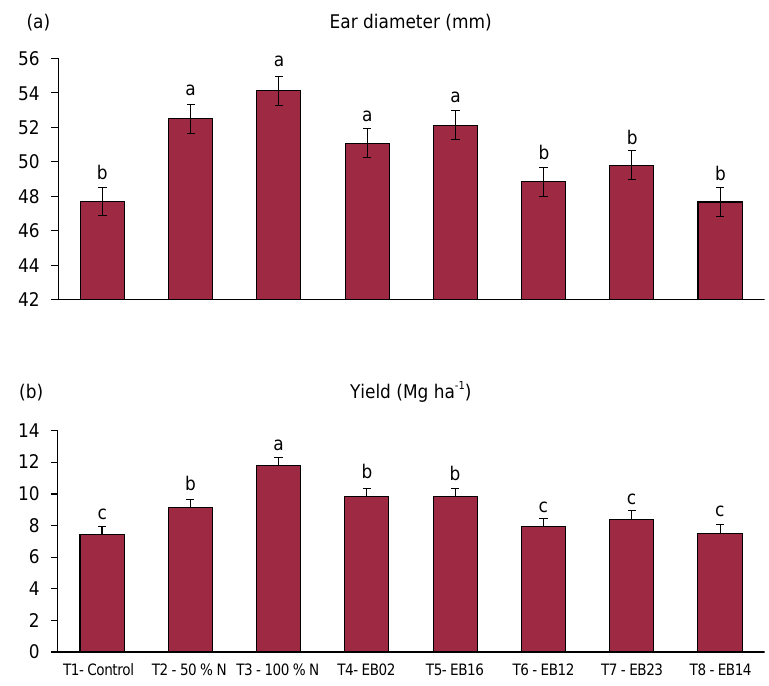
Figure 2. Bacillus sp. isolates effect on corn ear diameter (a) and yield (b). Average followed by the same letters does not differ by the Scott Knott test at 5